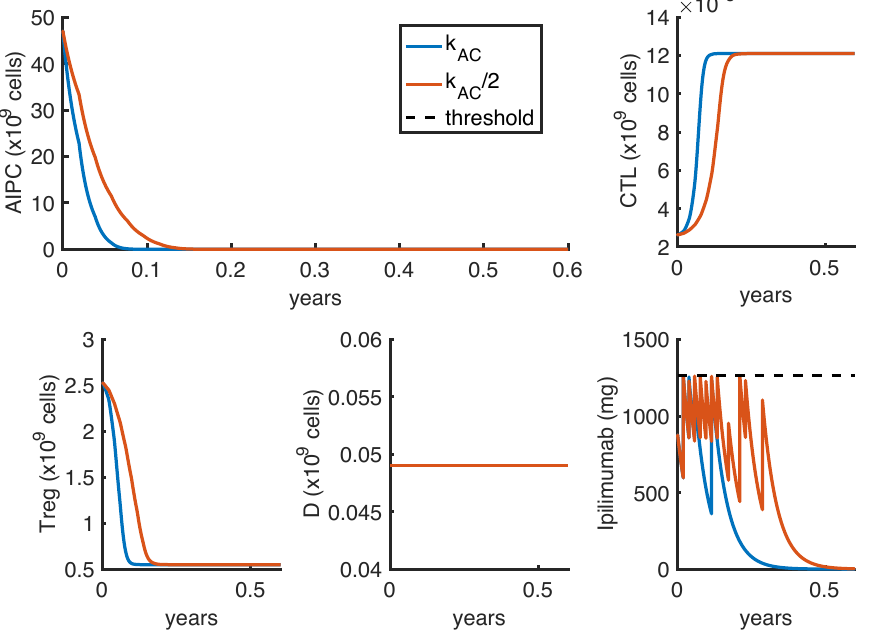
) and 1.81 ( k AC ). The ipilimumab threshold has been highlighted with a black dotted line. ( k AC 2 4